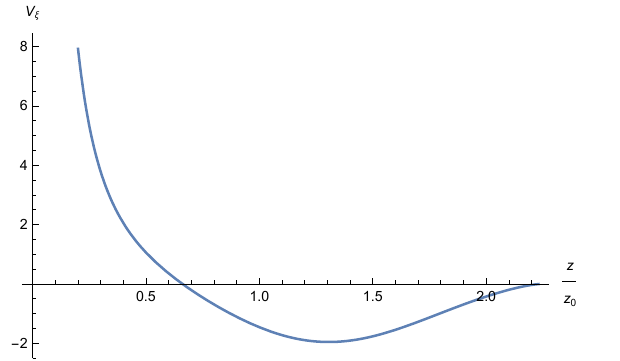
and as a function of z , where z is defined 0 z 0 z 2 0 0